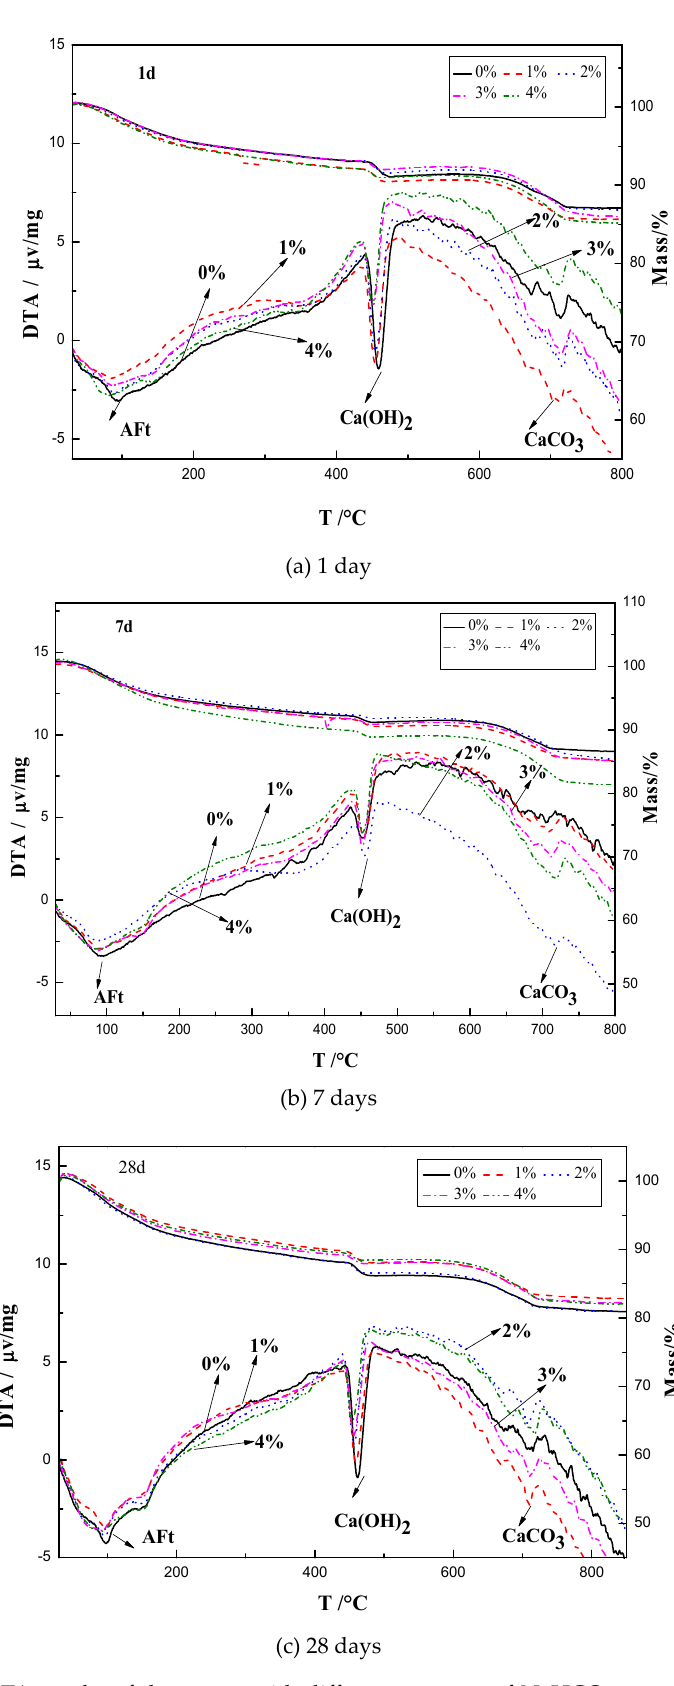
Figure 5. TG-DTA results of the pastes with different contents of NaHCO 3 at ages of ( a ) 1, ( b ) 7, and ( c ) 28 days.